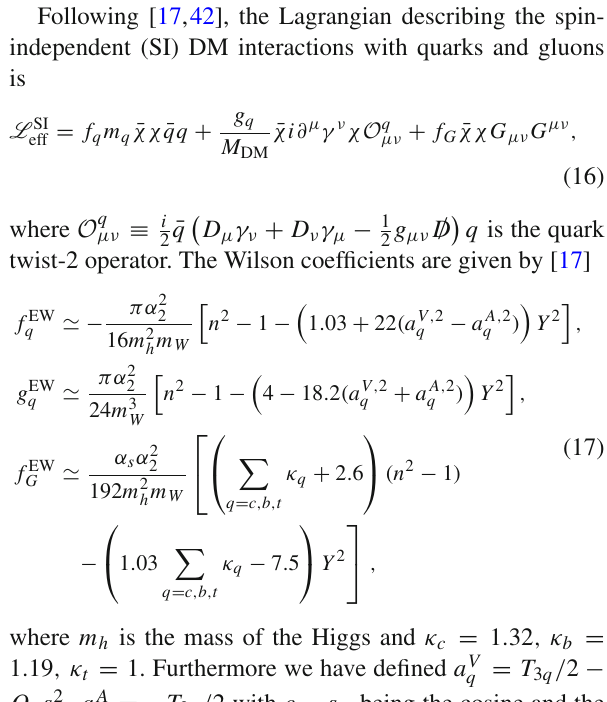
from the uncertainty in the theory determination of the WIMP freeze out mass in Table 1. The light green shaded region is excluded by the present experimental constraints from XENON1T [36] and PandaX- 4T [5], the green dashed lines shows the expected 95% CL reach of LZ/XENONnT [8,9] and DARWIN